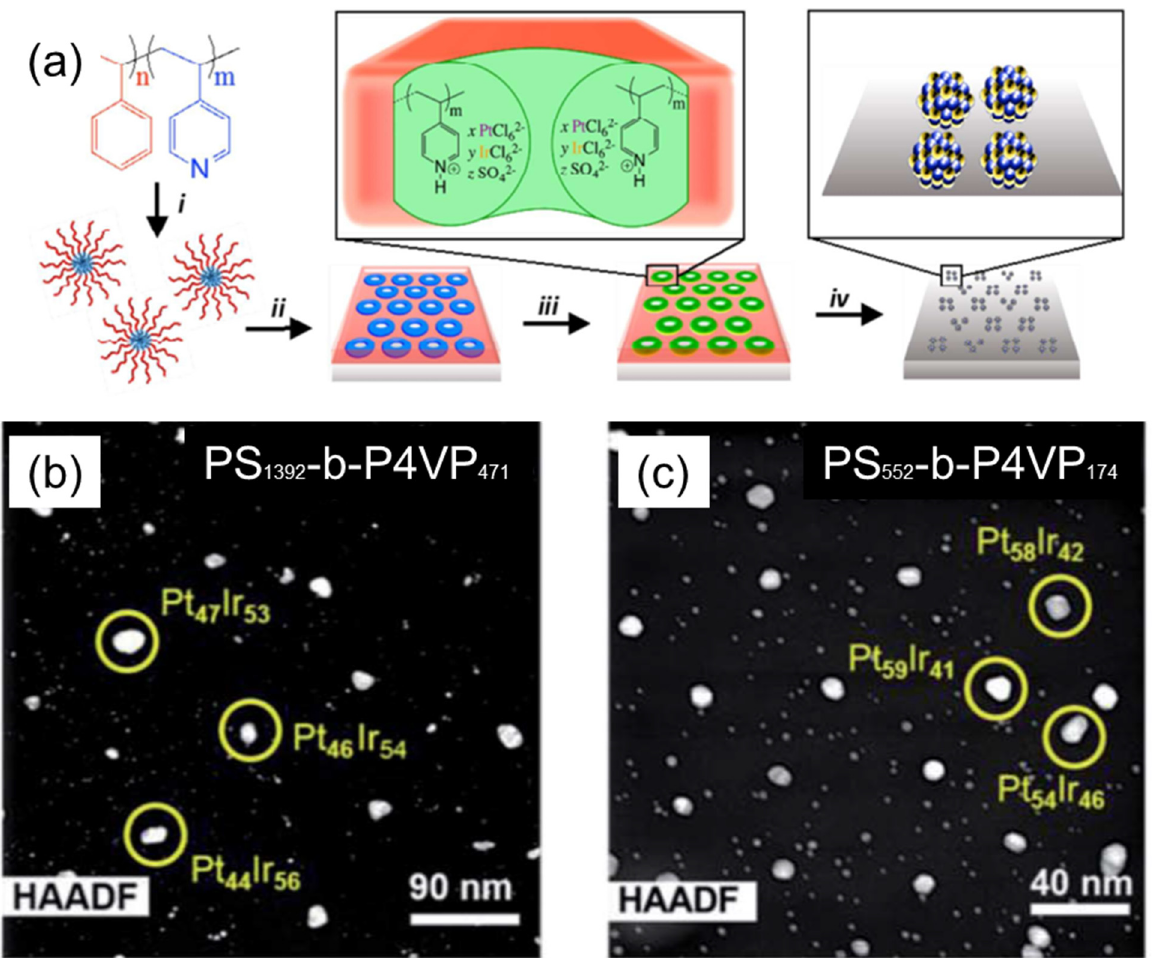
Figure 4. ( a ) Schematics of the synthetic procedure for the synthesis of PtIr bimetallic catalysts, using thin films of PS– b - P4VP micelles: (i) solution self-assembly of PS– b –P4VP into spherical micelles in toluene; (ii) spin-coating micelles onto an electrode substrate, followed by thin-film reconstruction into an array of inverted micelles by soaking in methanol; (iii) simultaneous loading of H2PtCl6 and H 2 IrCl 6 precursors into the P4VP domains; and (iv) thermoreductive annealing under Ar flow to remove PS– b –P4VP template and convert metal precursors into PtIr alloy NPs; ( b , c ) HAADF STEM images of PtIr NPs arrays derived from ( b ) PS 1392 - b –P4VP 471 and ( c ) PS 552 - b –P4VP 174 templates loaded with H 2 PtCl 6 + H 2 IrCl 6 at a stoichiometric ratio of 8:2 mol/mol. Subscripts in BCP assignments correspond to the number of monomer repeat units of each block. Adapted from [24].